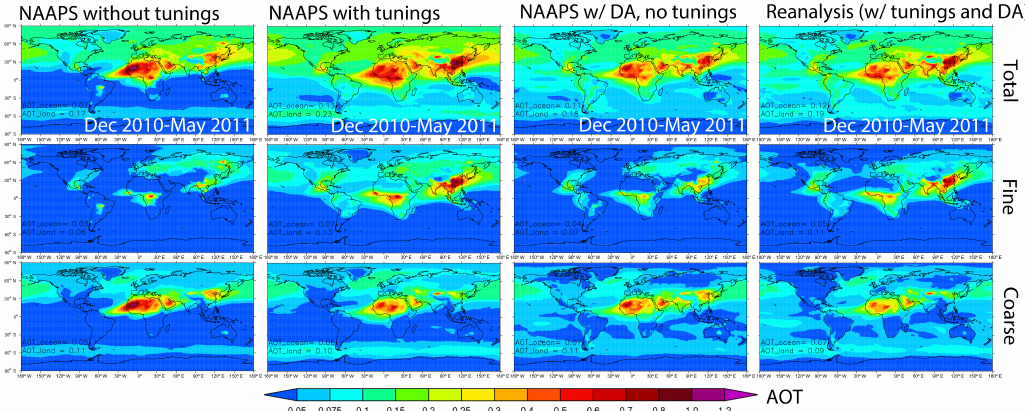
Figure A2. Same as the Fig. A1, except for December 2010–May 2011